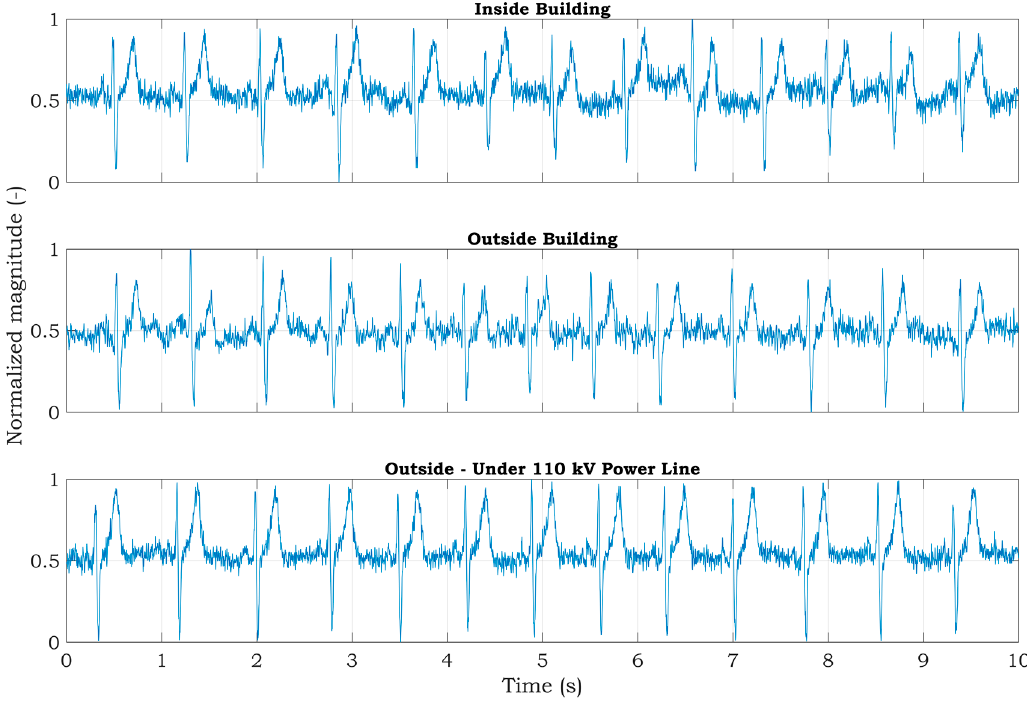
Figure 16. Raw ECG signals measured from a living subject by a battery-powered ECG device using the first power-line noise suppression method.